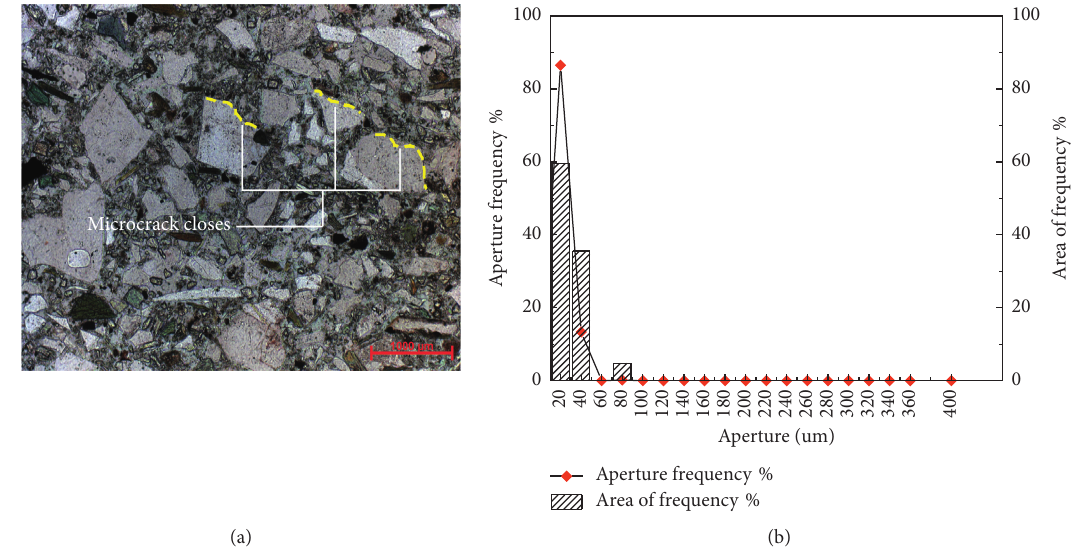
Figure 6: Compaction stage of the cast thin section. (a) Slice image. (b) Pore statistical